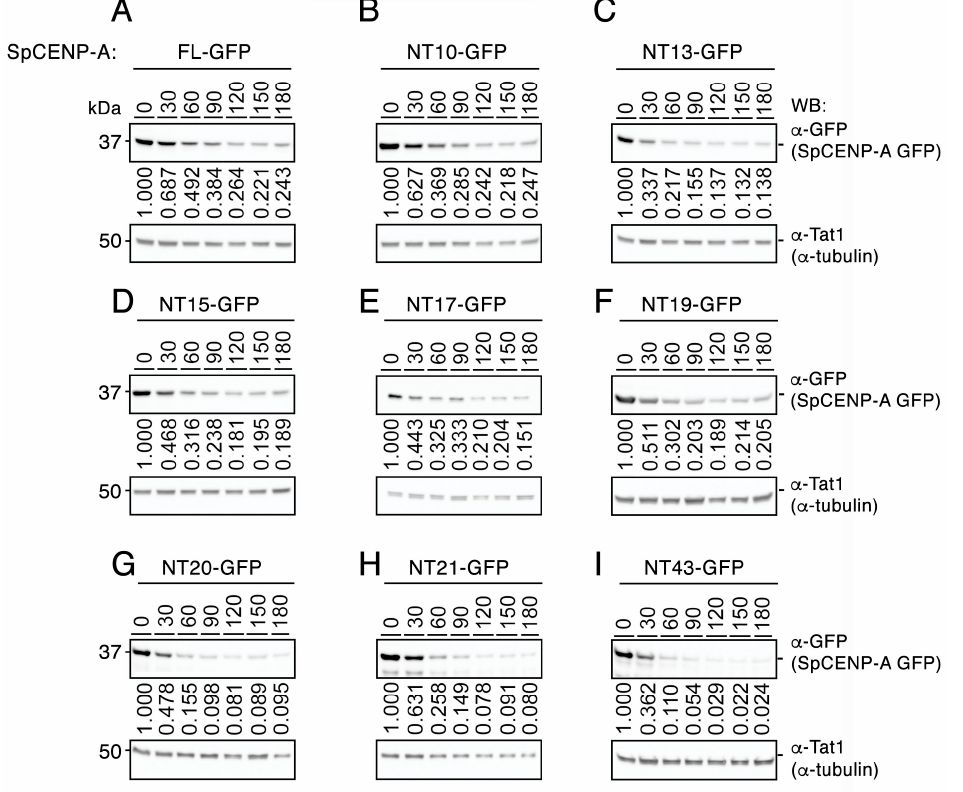
Figure 2. Truncation of the SpCENP-A NTD does not confer resistance to proteolytic degradation. Evaluation of exogenously expressed protein levels of GFP-tagged SpCENP-A N -terminal truncation mutants (NT-GFP) in a cycloheximide (CHX; 100 µ g / mL) chase assay at 30 ◦ C, 18 h post-induction after thiamine withdrawal. ( A ) FL-GFP, full-length SpCENP-A GFP-tagged protein, ( B ) NT10-GFP, ( C )NT13-GFP,( D )NT15-GFP,( E )NT17-GFP,( F )NT-19-GFP,( G )NT20-GFP,( H )NT21-GFP,( I )NT43-GFP. Tat1 ( α -tubulin), loading control; kDa, kilodalton; WB, western blotting. Relative protein enrichment from time 0 min (at 30 min intervals) to 180 min after exposure to CHX. Representative of two independent